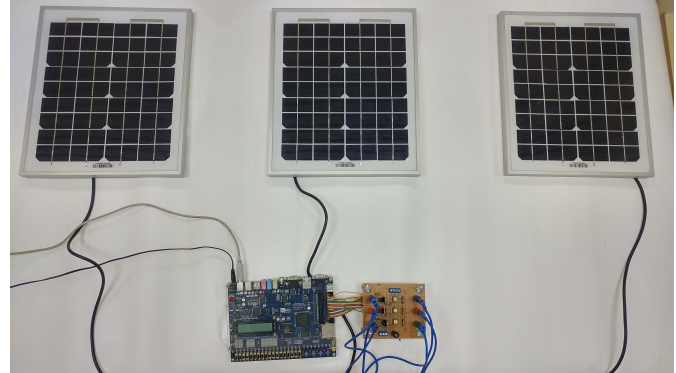
Figure 16. The experimental setup with three PS10M-12/B PV modules connected in series, loads, and electronic control.